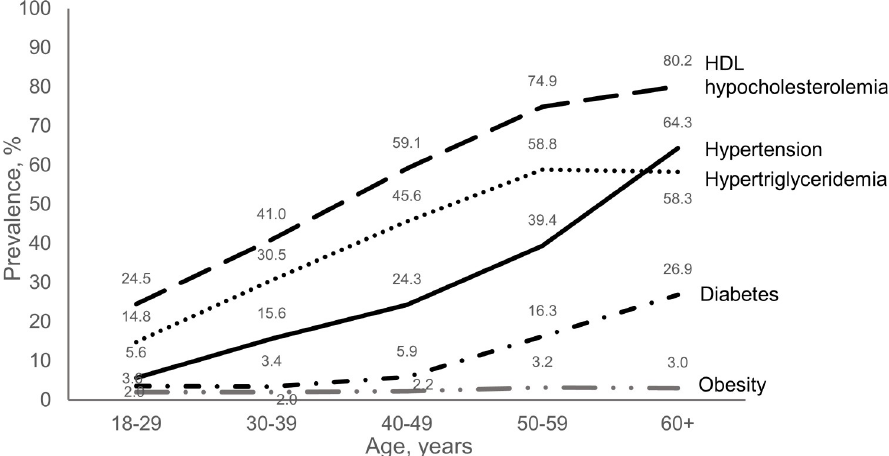
Fig 2. Age-specific prevalence of metabolic abnormalities among people living with HIV on follow-up between 2015 and 2017.